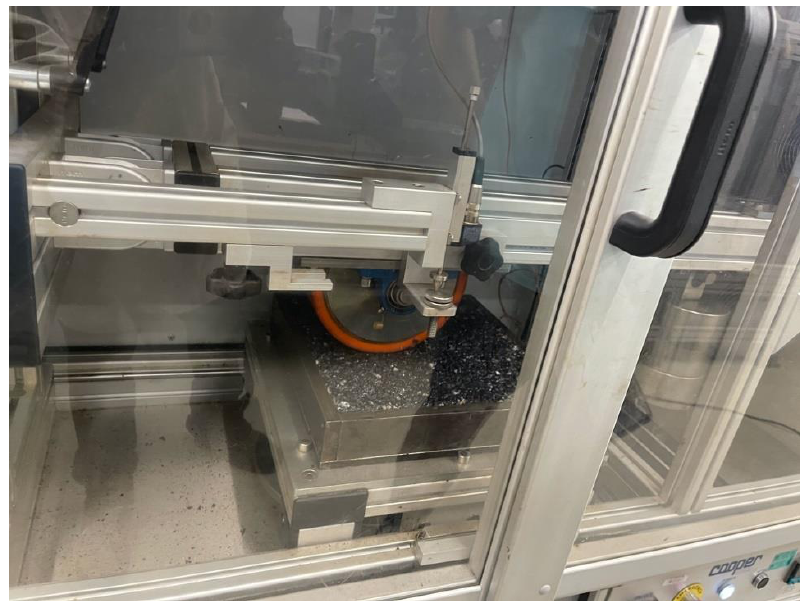
Figure 3. Wheel-tracking test. Table 9. Wheel tracking test parameters from AG:PT/T231 Reprinted from ref.